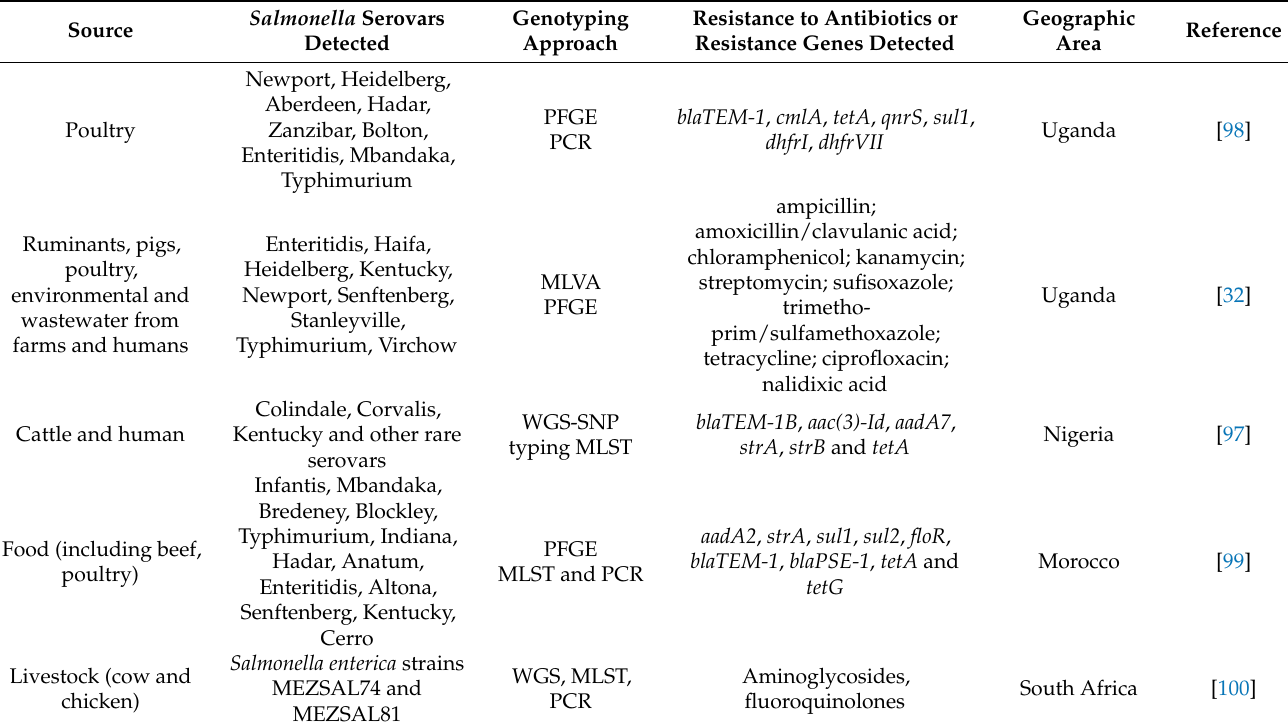
Table 3. Studies which used genotyping approaches to report antimicrobial resistant Salmonella serovars in food animals in